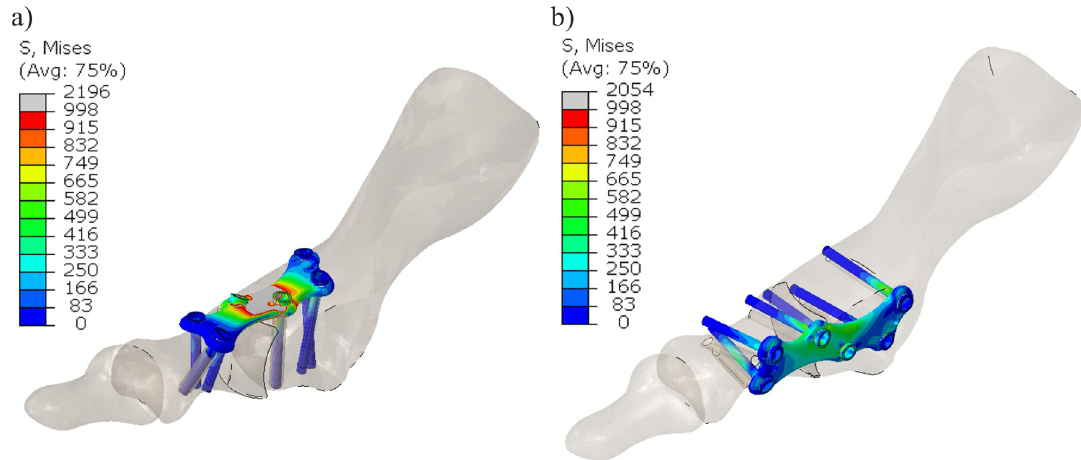
Fig 11. Contour maps of the effective stress [MPa] for models with a) a dorsal plate and b) a medial plate.